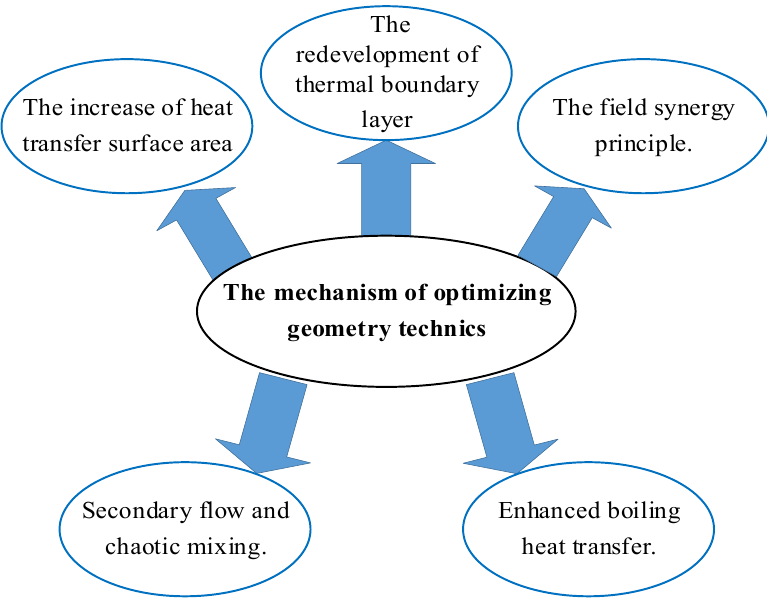
Figure 2. The mechanism of optimizing geometry